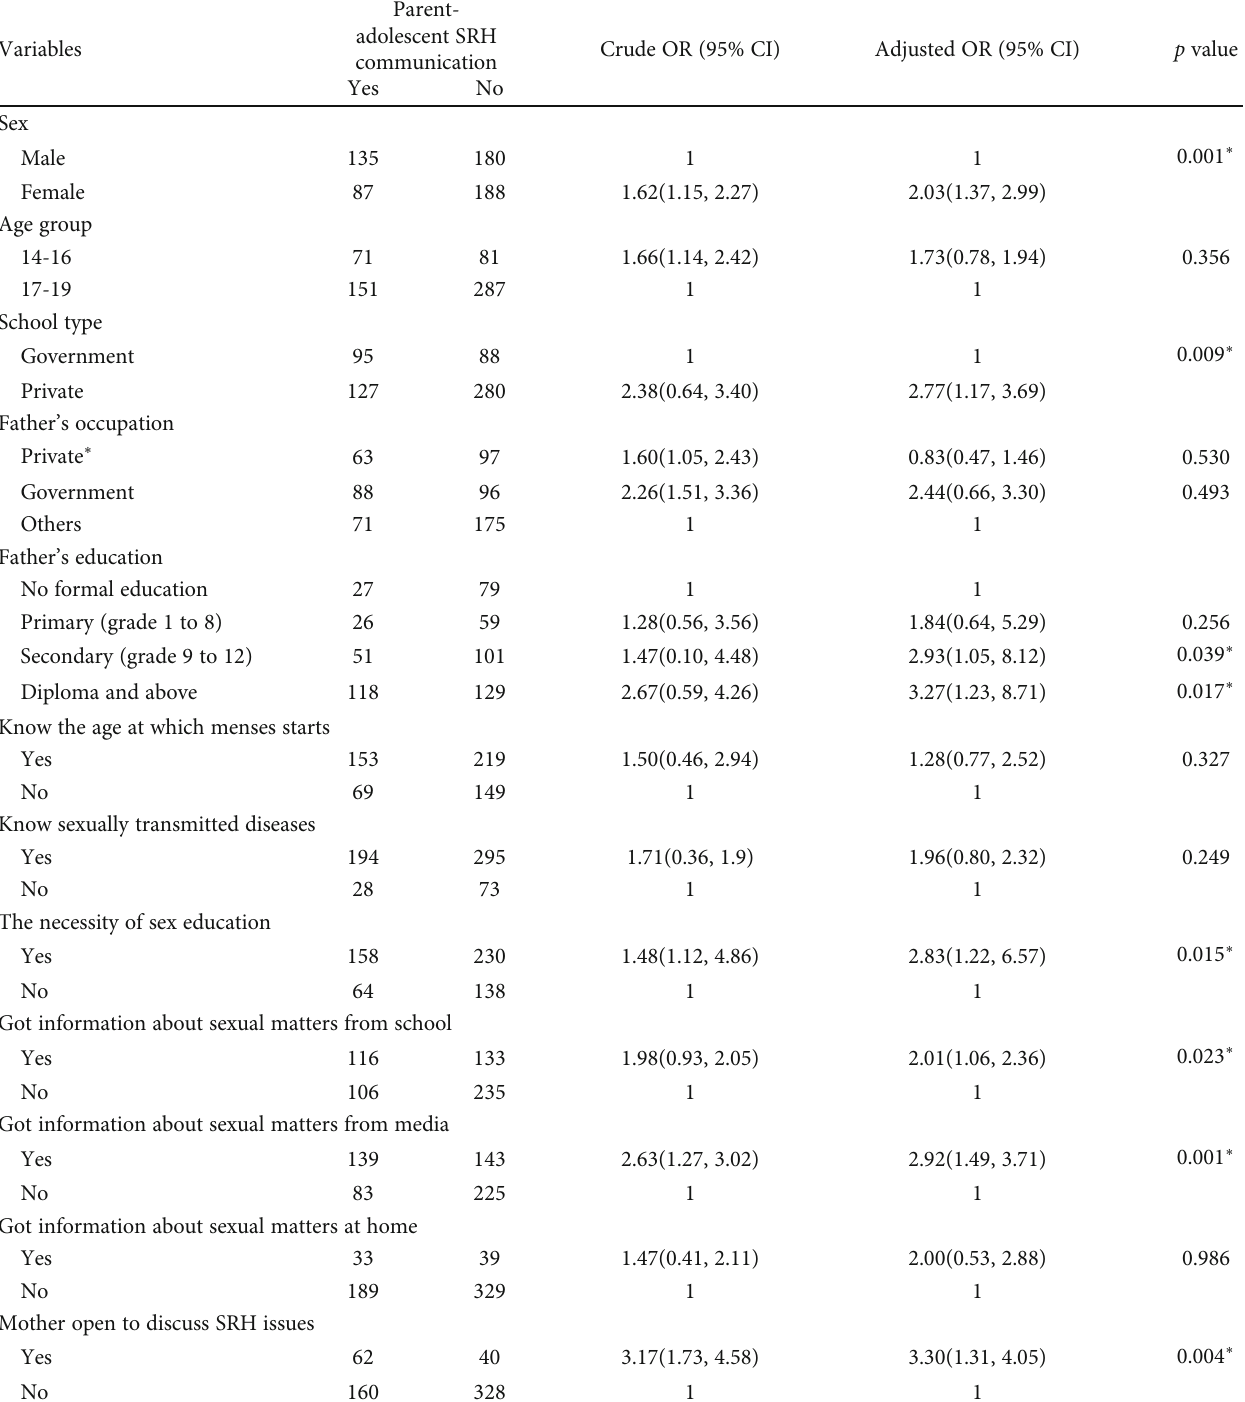
Table 5: Factors associated with parent-adolescent communication on SRH issues among secondary and preparatory school students in Ambo Town, Oromia region, Ethiopia,